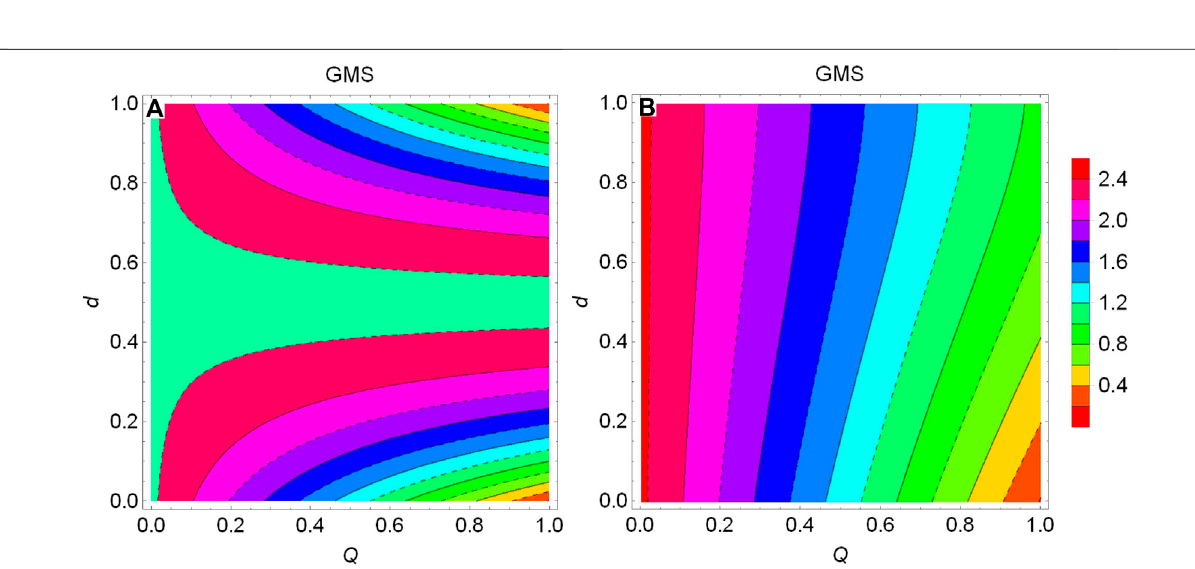
FIGURE 5 | (Color online) Contour plot of GMS inequality versus the state parameter Q and the channel-noise factor d with α (cid:2) channels. (A) BF channel. (B) PD channel.